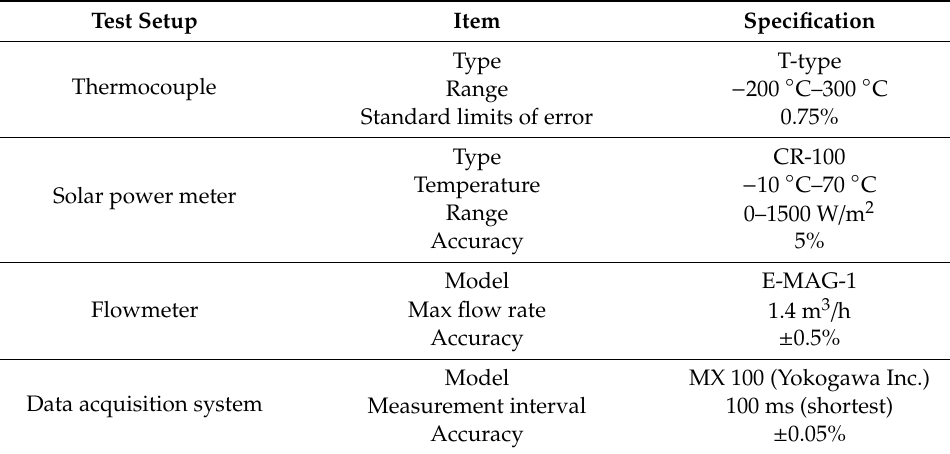
Figure 2. Schematics of the solar collector system. Table 1. Specifications of the experimental